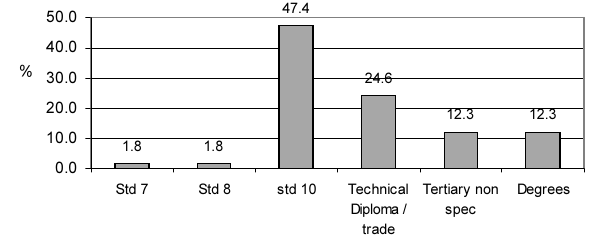
Figure 3: Qualifications of skilled